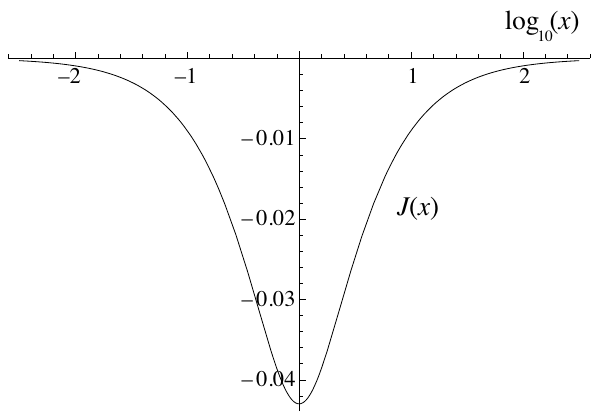
Figure 10. The function J ( x ) computed from the integral (69) by numerical integration.